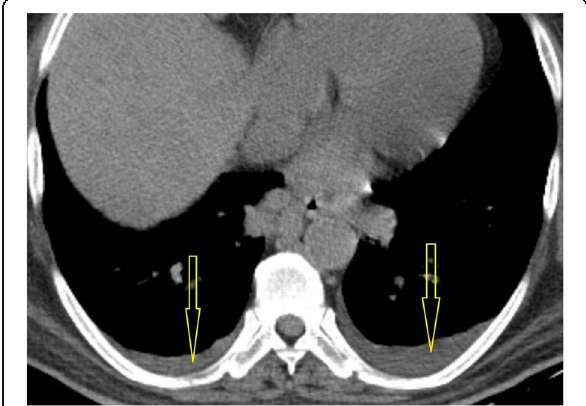
Fig. 8 CT scan of COVID-19 patient shows minimal bilateral pleural effusion (yellow